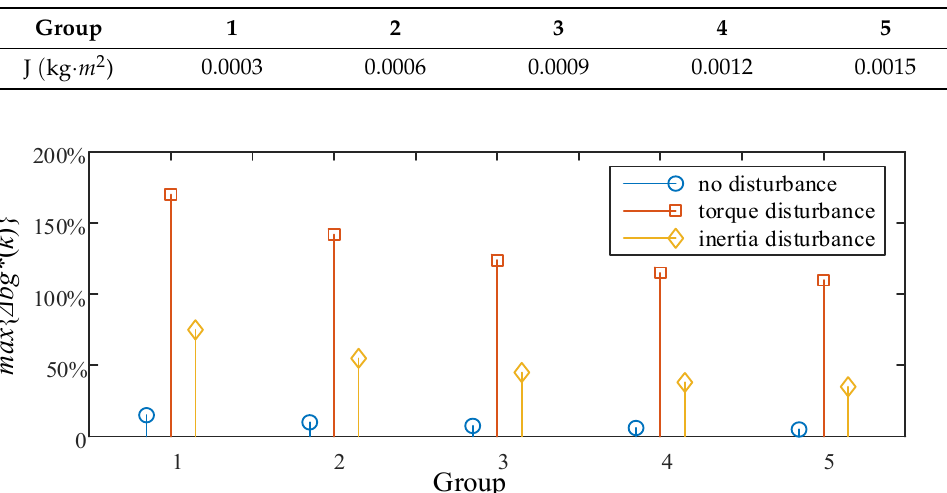
Table 1. Grouping of simulation.